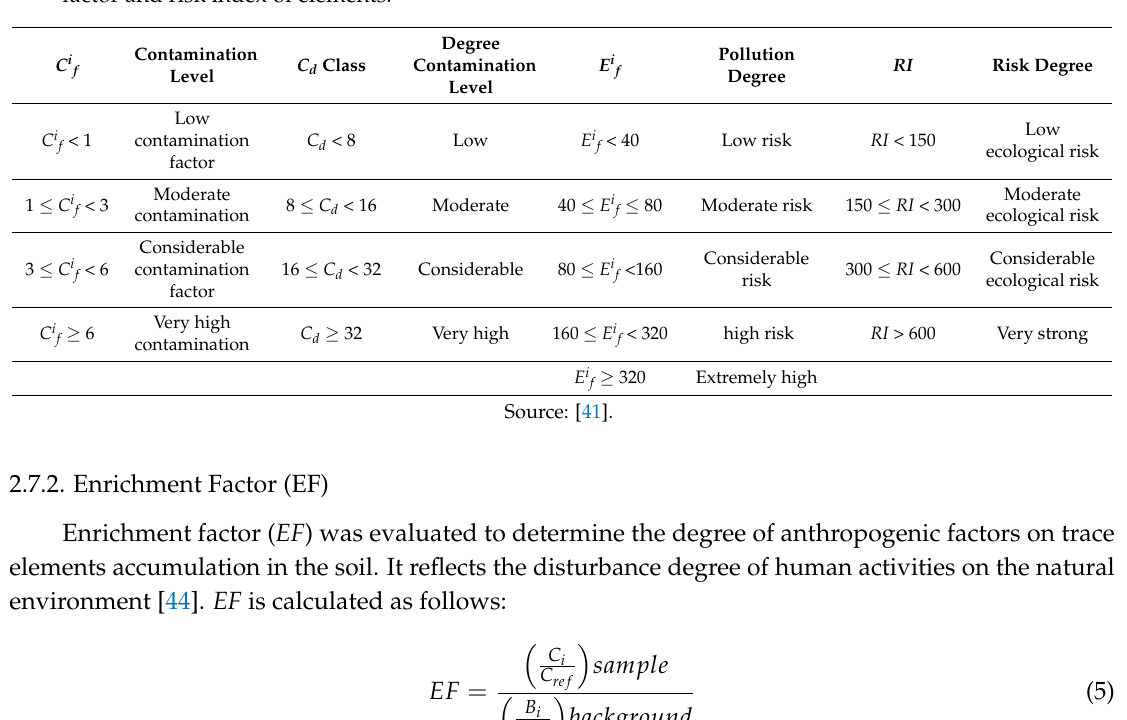
Table 1. The standard given for the contamination factor, degree of contamination, ecological risk factor and risk index of